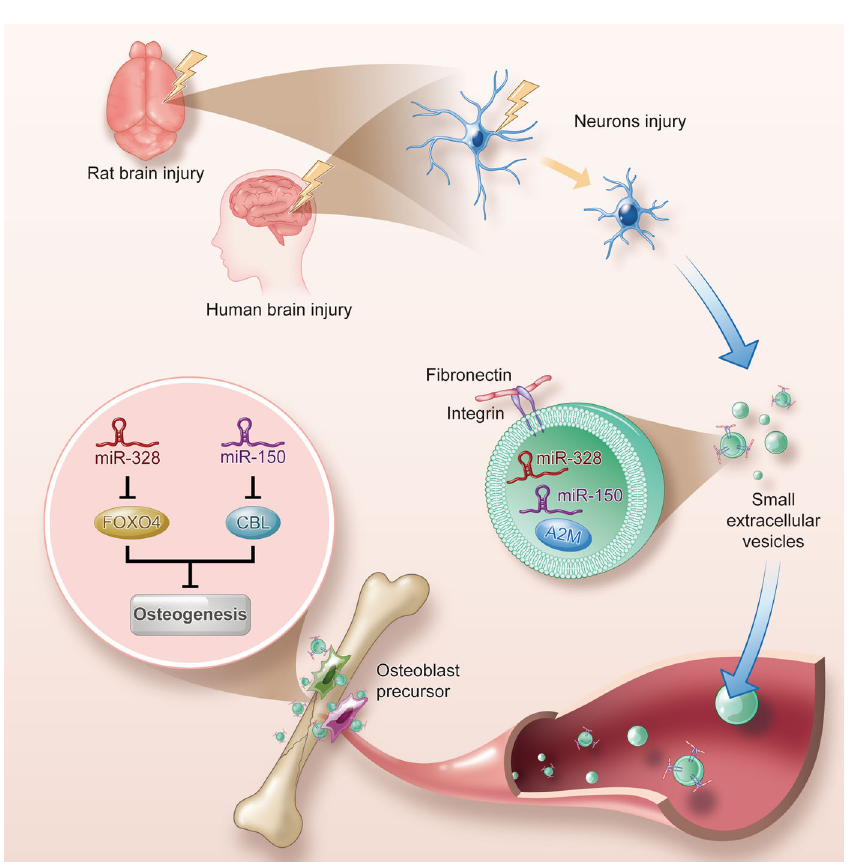
Fig. 8 Scheme of the mode of damaged brain accelerates bone healing by releasing sEVs that target osteoprogenitors. After TBI, the injured neurons released osteogenic miRNA-enriching sEVs, which were transferred to bone through the circulatory system, and target osteoprogenitors to promote osteogenesis and accelerate bone healing. The increased FN1 expression on sEVs surface contributed to direct sEVs to target osteoprogenitors. miR-328a- 3p and miR-150-5p enriched in plasma sEVs after TBI were strong osteogenic miRNAs, which had potent potential to repair bone by directly targeting FOXO4 and CBL 3 ′ -UTR,